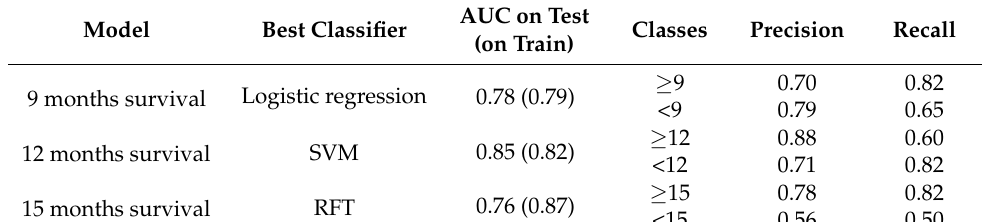
Table 5. Results metrics of the classification models on the test sets. Model Best Classifier